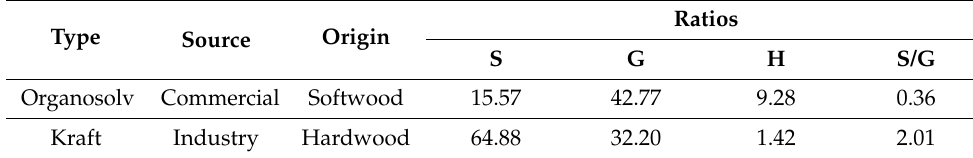
Table 1. Source, origin, and monolignols ratios of used